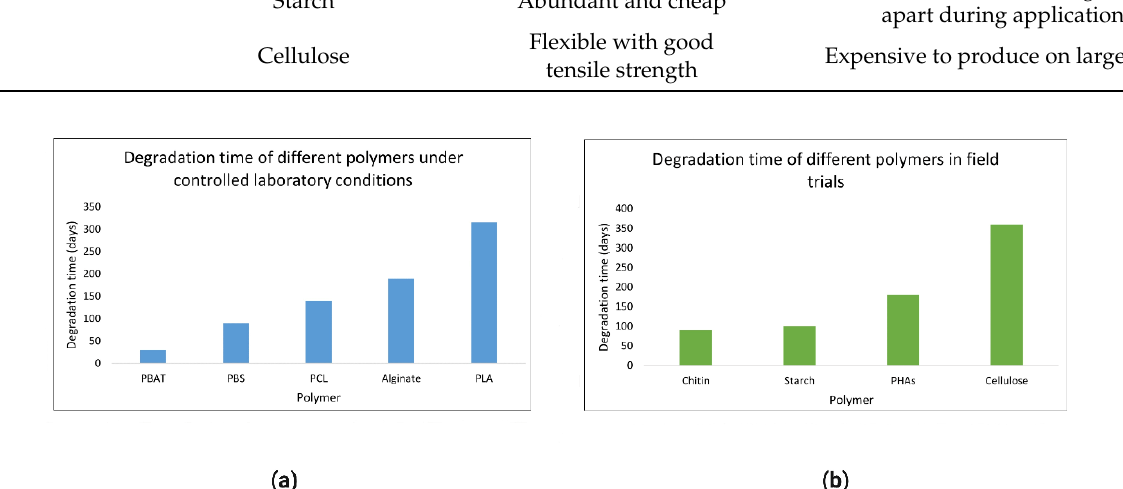
Figure 12. The degradation time estimated for different biodegradable polymers ( a ) under controlled conditions and ( b ) in field trials.